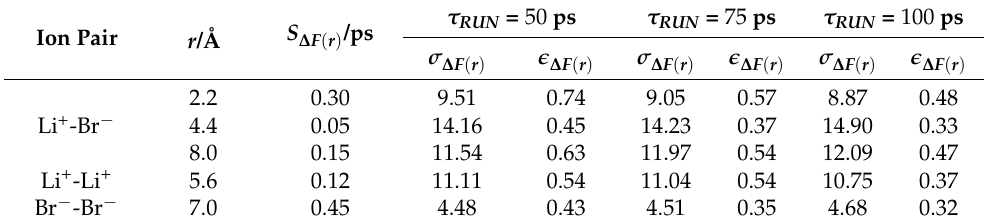
Table 5. Error estimates: value to the ion–ion PMF ( k B T /Å).